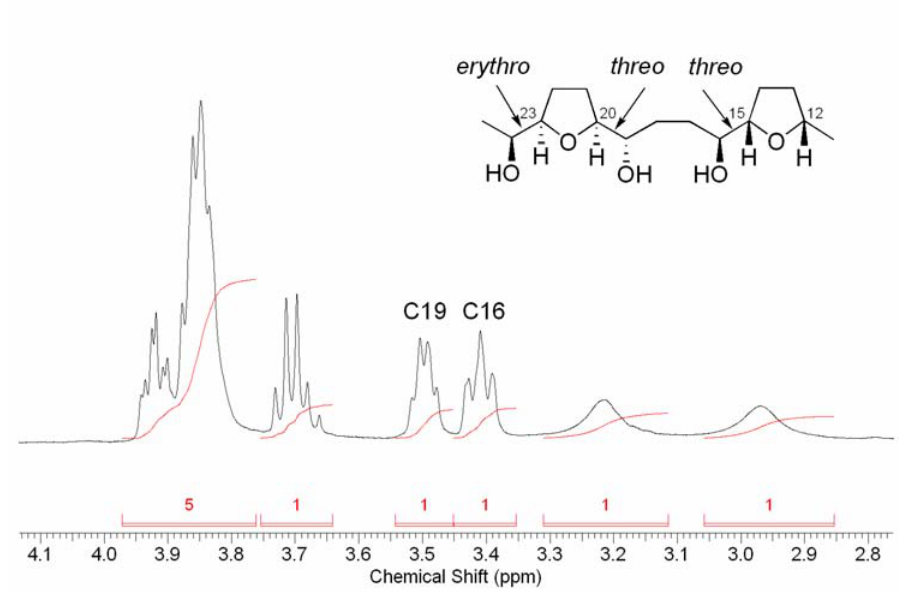
Figure 4. Partial 1 H-NMR spectrum of cis -sylvaticin ( 3 ) showing carbinol methine resonances for threo configured hydroxyalkyl THFs (C15/C16 and